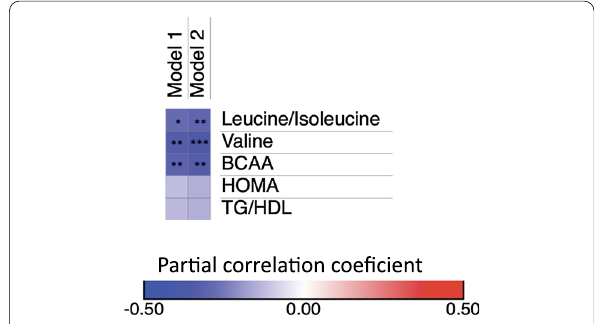
Fig. 5 Association of 16S Faecalibacterium genus abundance with BCAA serum levels and insulin resistance markers in the extended dataset (N 124). P‑values were calculated using partial spearman = correlations adjusted for Model 1: age and sex. Model 2: